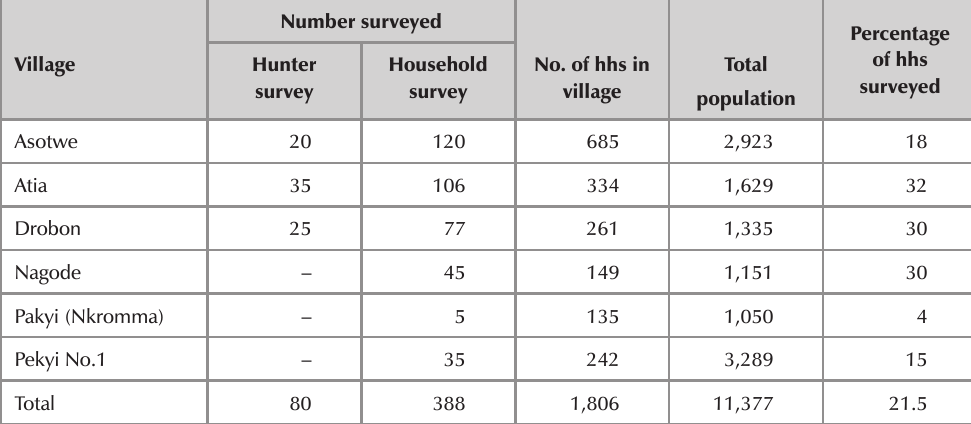
Sample characteristics of the surveyed villages. Most household sizes averaged between 4 and 8 persons. An exception was Pekyi No.1 where the household sizes averaged almost